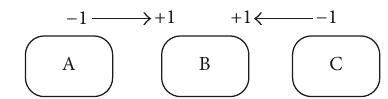
Figure 8: Particles example: two particles proposed to cell B.